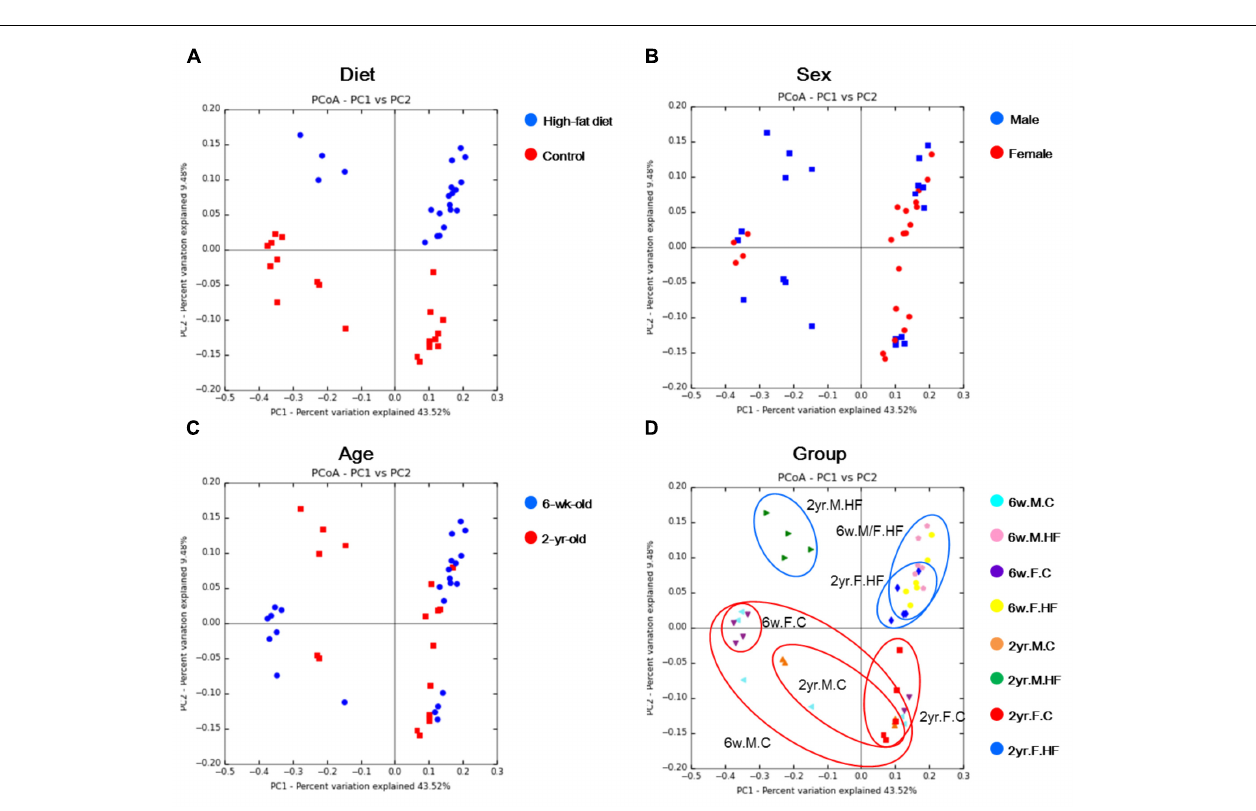
FIGURE 1 | Calorie intake (A) and changes in body weight (B) during the 8-week feeding of control or high-fat diet (6-week-old rats, n = 6; 2-year-old male rats, n = 4; 2-year-old female rats, n = 5). Data are expressed as mean and SEM; p -values to Kruskal–Wallis test is designated on the figure; ∗ p < 0.05 according to Mann–Whitney U -test with Holm–Bonferroni correction; M, male; F, female; HF, high-fat diet.